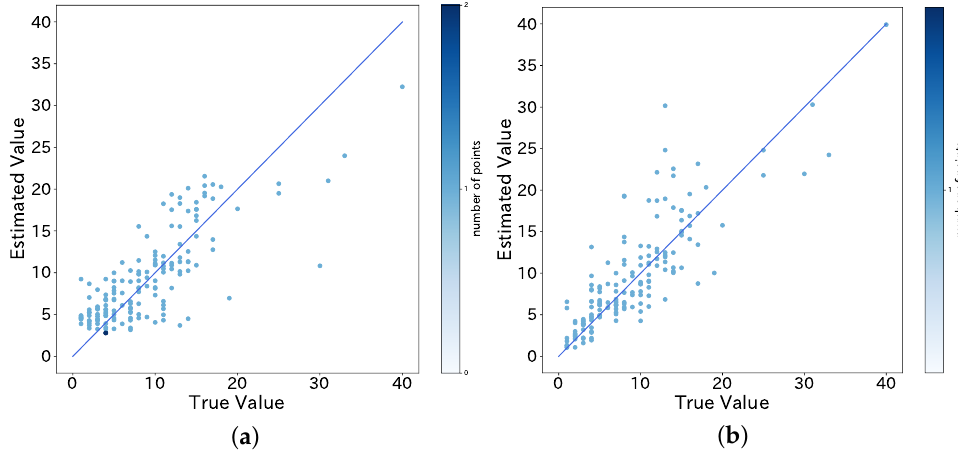
Figure 9. Values estimated by machine learning versus true values (number of passengers). ( a ) XGB (ND); ( b ) XGB (ND +